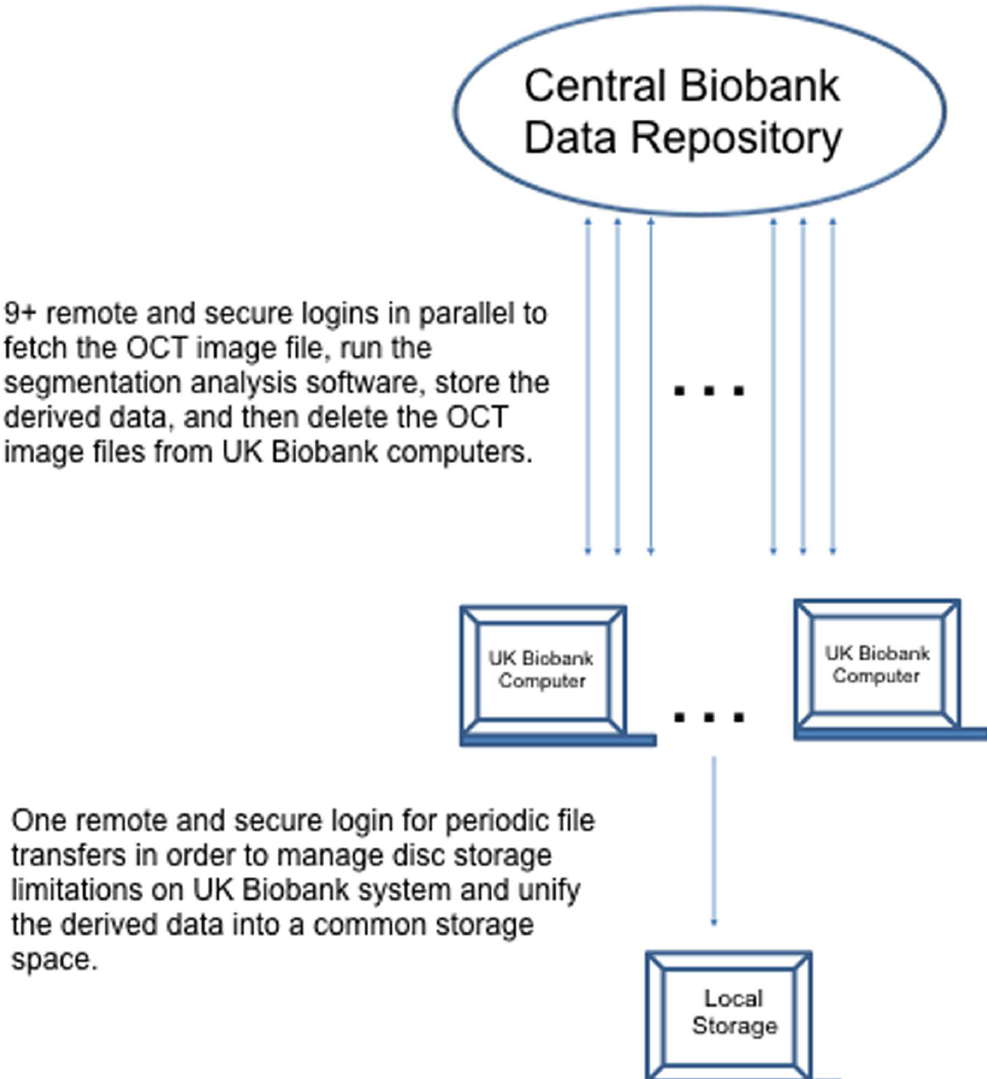
Fig 2. UK Biobank Data Processing Scheme. The source data (optical coherencetomography (OCT) image sets) were stored on a central repository and accessed via remote, secure